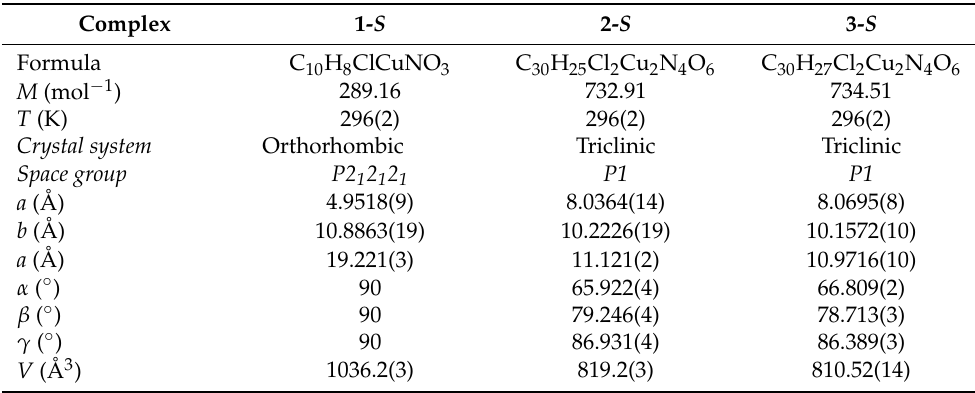
Table 1. Crystallographic data for 1- S , 2- S and 3- S